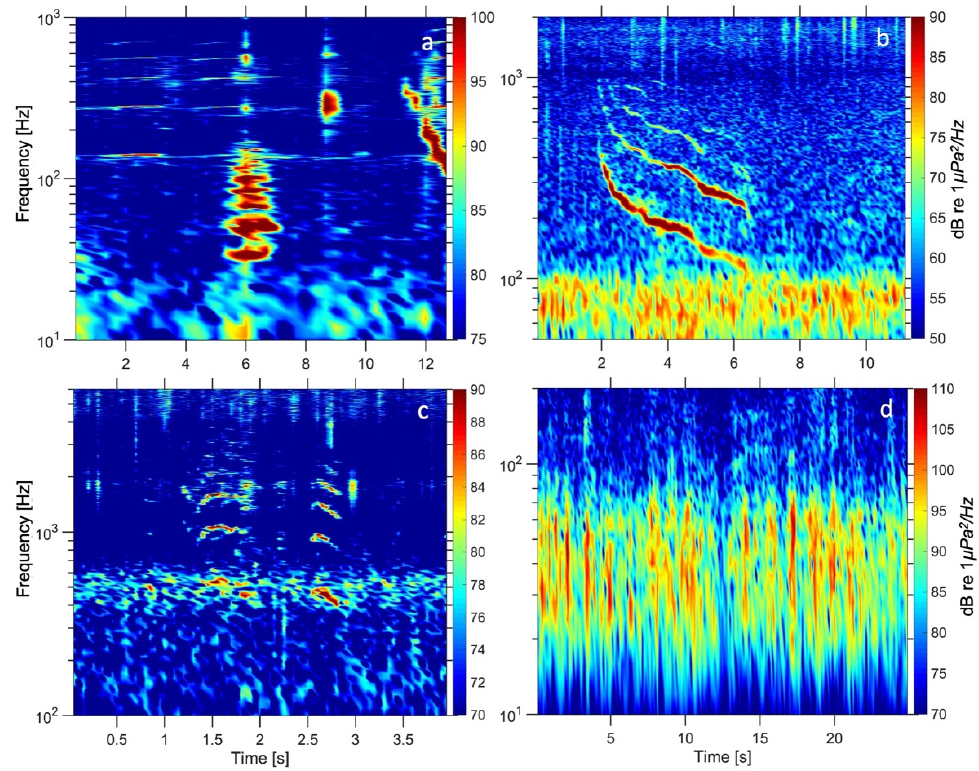
Figure 5. Spectrograms of a wide-band constant-wave call ( a ) and a harmonic down-sweep of unknown origin ( b ), vocalisations likely produced by the African penguin in air (but recorded under water: ( c ), and a chorus with unknown origin ( d ). Note that the frequency axis and colour bars have different ranges.